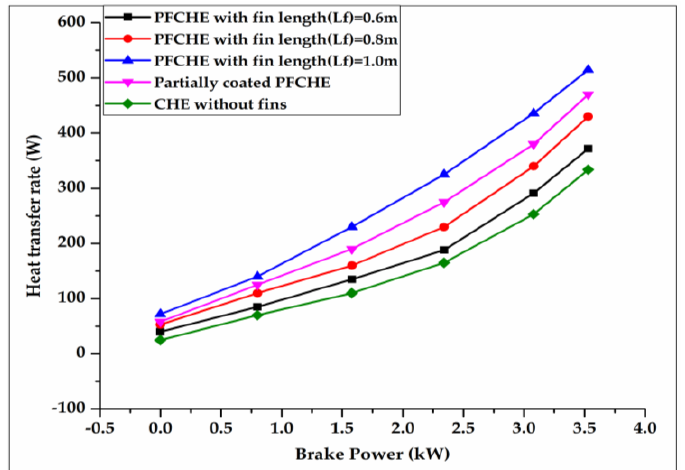
Figure 6. Variation of heat transfer rate with fin geometry.